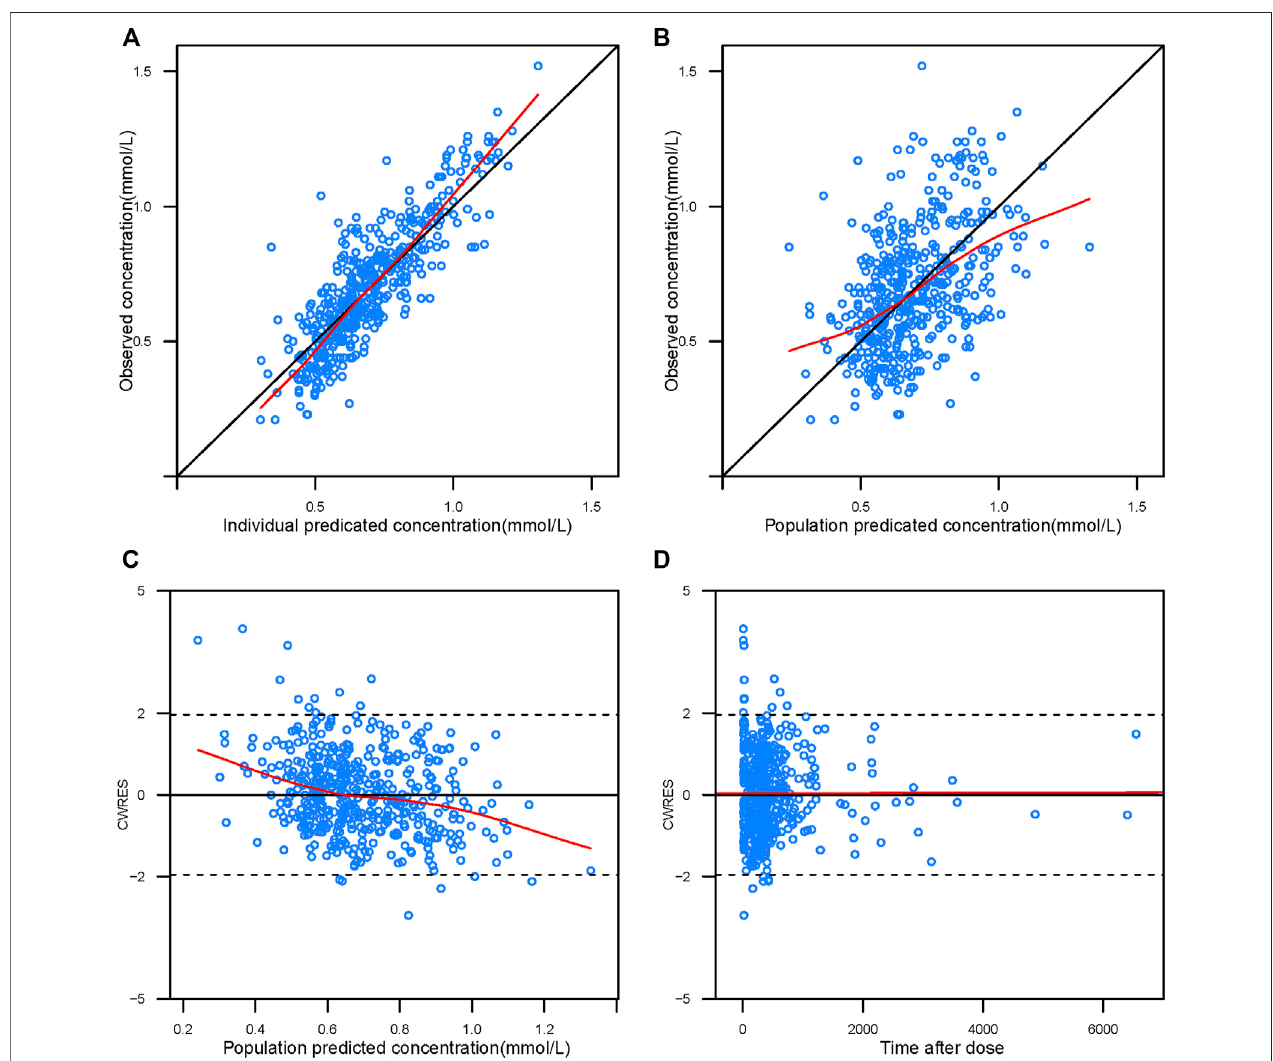
FIGURE1| Goodness-of- fi tplotsofthe fi nalpopulation-pharmacokineticmodel. Theupper leftplotrepresents theobservations versusthepopulationpredictions (A) . The upper right plot represents the observations versus the individual predictions (B) . The lower left plot represents the conditional weighted residuals versus the population predictions (C) . The lower right plot represents the conditional weighted residuals versus the time after dose (D) . The red line represents the locally weighted scatterplot smoothing line.